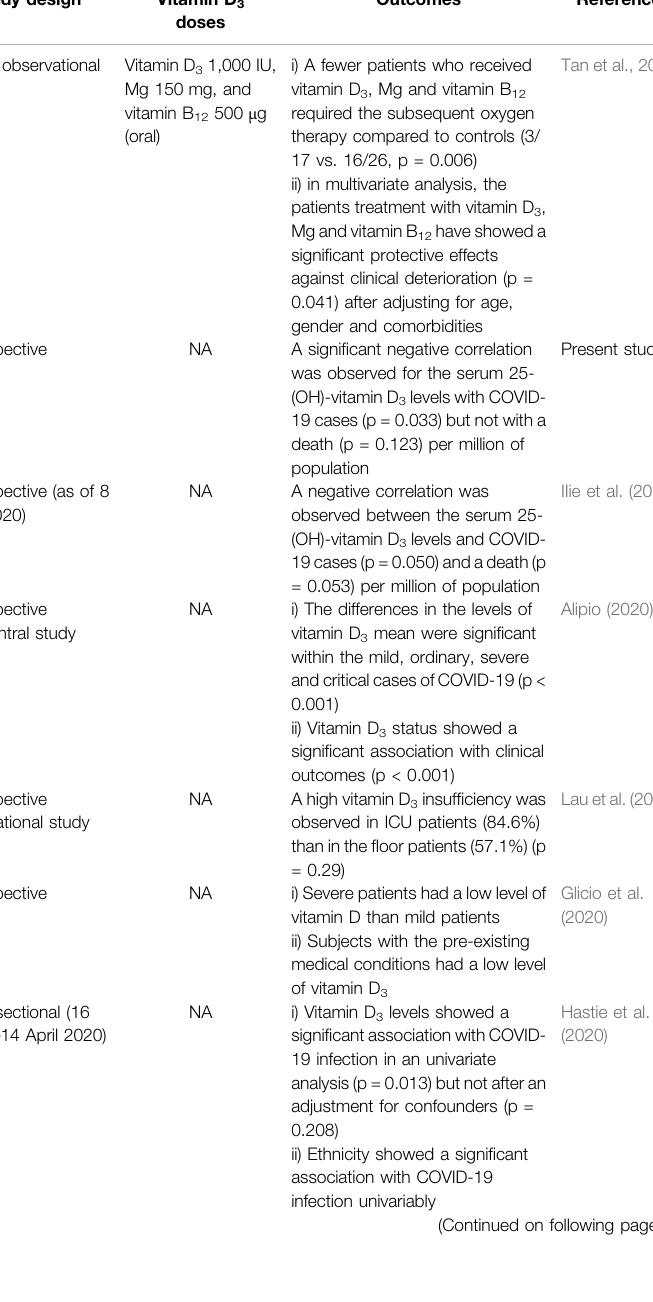
TABLE 3 | The outcomes in recent studies about the correlation of vitamin D 3 concentrations with COVID-19 infections.